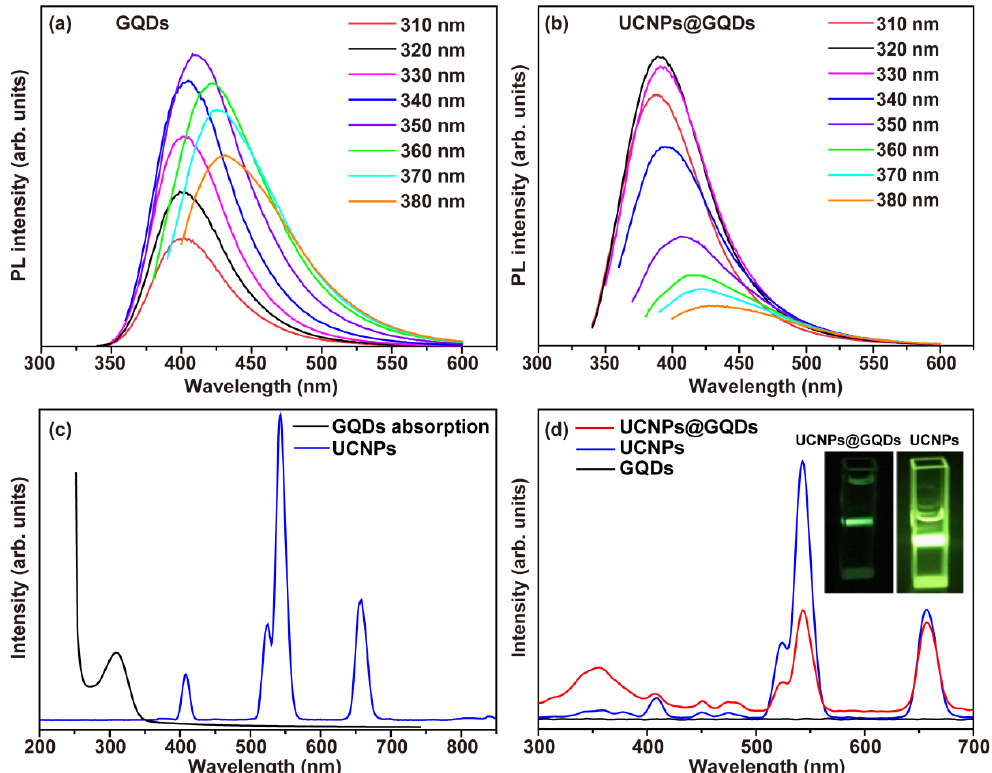
Figure 2. Optical properties of UCNPs@GQDs. ( a ) PL spectra of GQDs detecting with different excitation wavelengths. ( b ) PL spectra of UCNPs@GQDs detecting with different excitation wavelengths. ( c ) The spectral overlap of GQDs absorption and UCNPs emission ( λ ex = 980 nm). ( d ) Upconversion luminescence spectra of UCNPs@GQDs, UCNPs, and GQDs ( λ ex = 980 nm). The insert is the photograph of UCNPs@GQDs and UCNPs upon 980 nm laser irradiation.